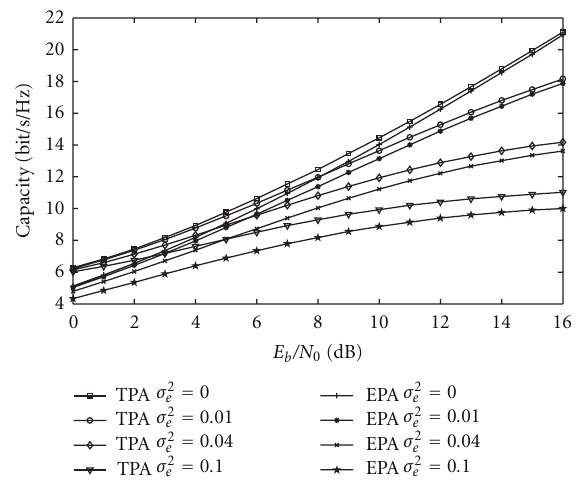
Figure 2: Capacity performance of traditional and modified Turbo- BLAST systems with four transmit and four receive antennas under the conditions of di ff erent inaccuracy of channel estimation.